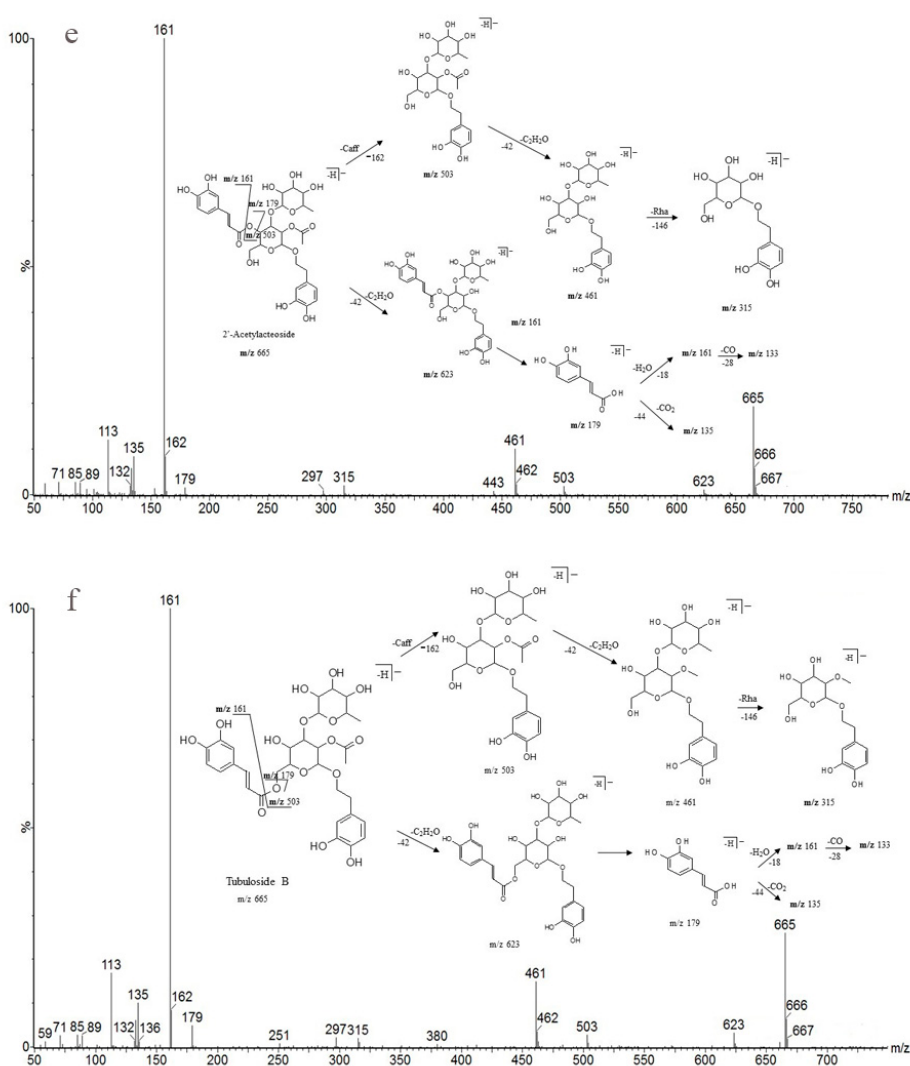
Figure 7. Detailed MS spectra and the proposed fragmentation patterns of Echinacoside ( a ); Cistanoside A ( b ); Acteoside ( c ); Isoacteoside ( d ); 2 ′ -Acetylacteoside ( e ); Tubuloside B ( f ).